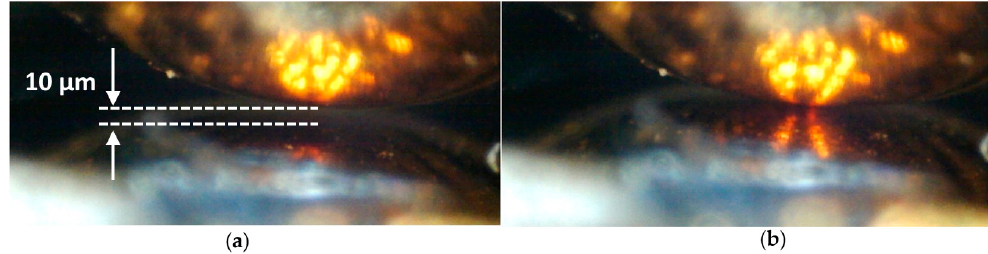
Figure 4. The contact pair shown through the 400× integrated video microscope ( a ) with a 10 µm separation between contacts and ( b ) in contact.